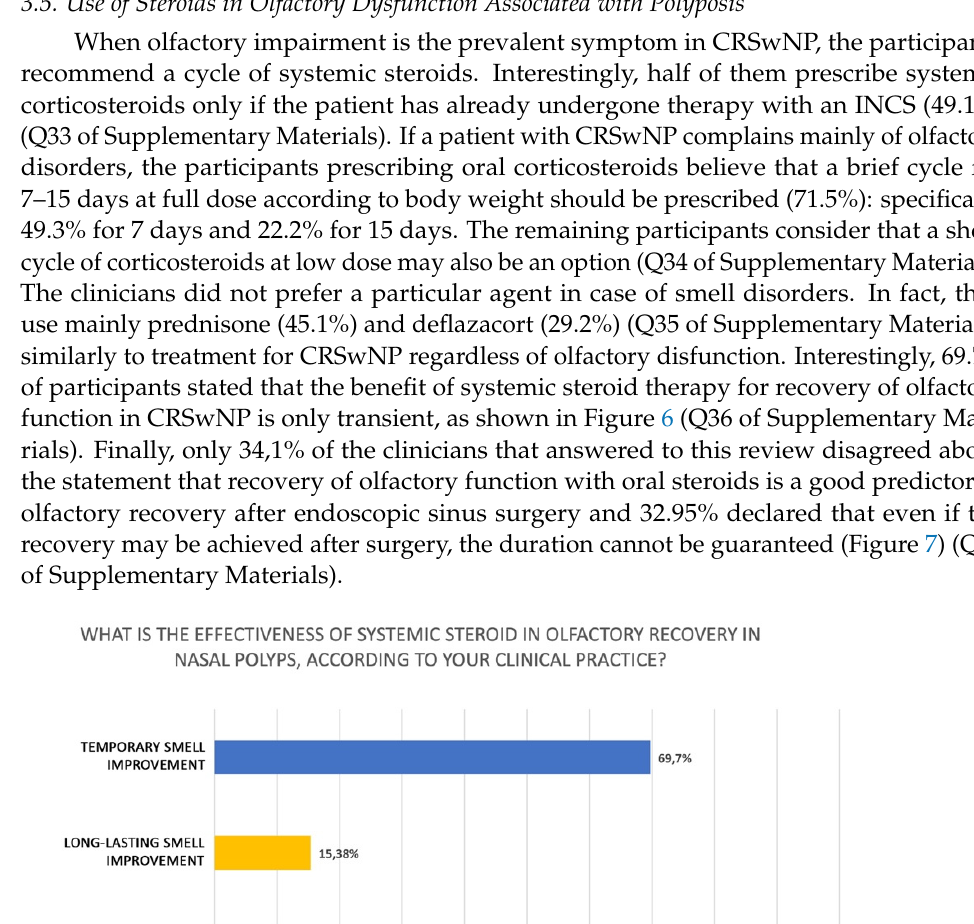
Figure 7 Perceived efficacy of oral corticosteroids on long-term control of olfaction (Q37 of Supple- mentary Materials File). 4. Discussion To the best of our knowledge, the present survey, involving a large number of Italian ENTs, is the only one assessing the use of local and systemic steroids in routine practice in patients with CRSwNP. One strength is the large number of participants which is likely to be representative of clinical ENT practice in Italy including around 6000 physicians. Several areas of agreement as well as lack of consistency in practice can be noted, high- lighting unmet needs and calling for clarity in the management of this disease.